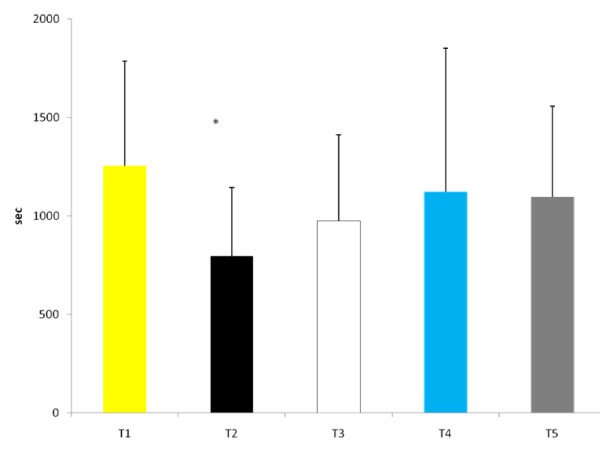
Time to Exhaustion. * Significantly different from all other trials.